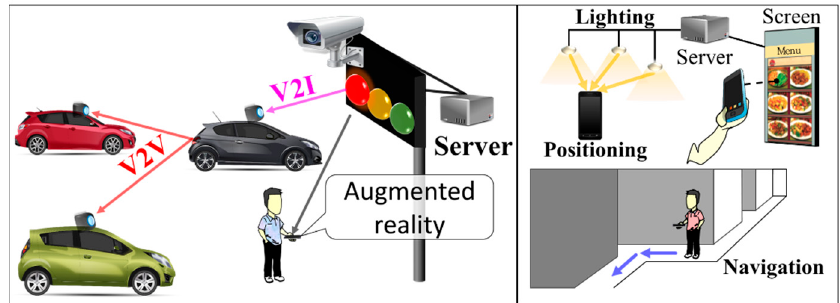
Figure 4. Example of promising services in IEEE 802.15.7m.